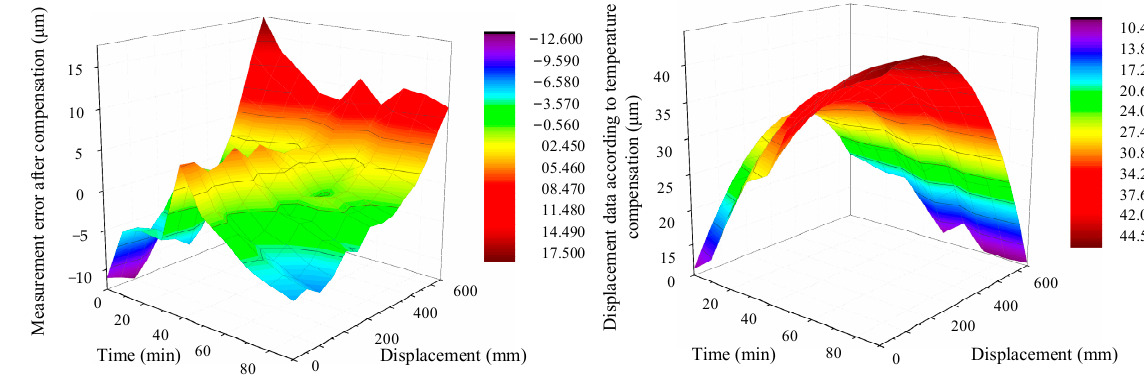
Figure 21. Plot of predicted geometric and thermal errors after compensation.